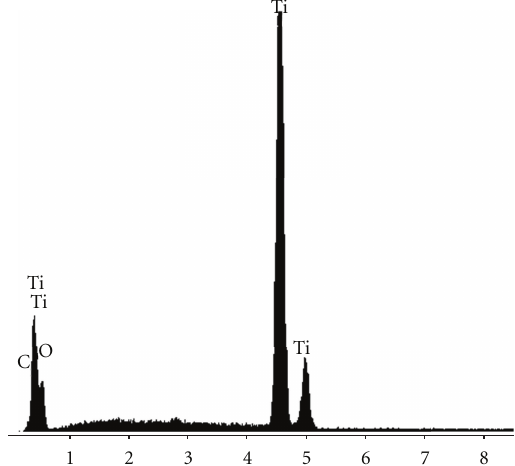
Figure 11: EDS spectrum acquired on the surface showed in the SEM image pictured in Figure 10.